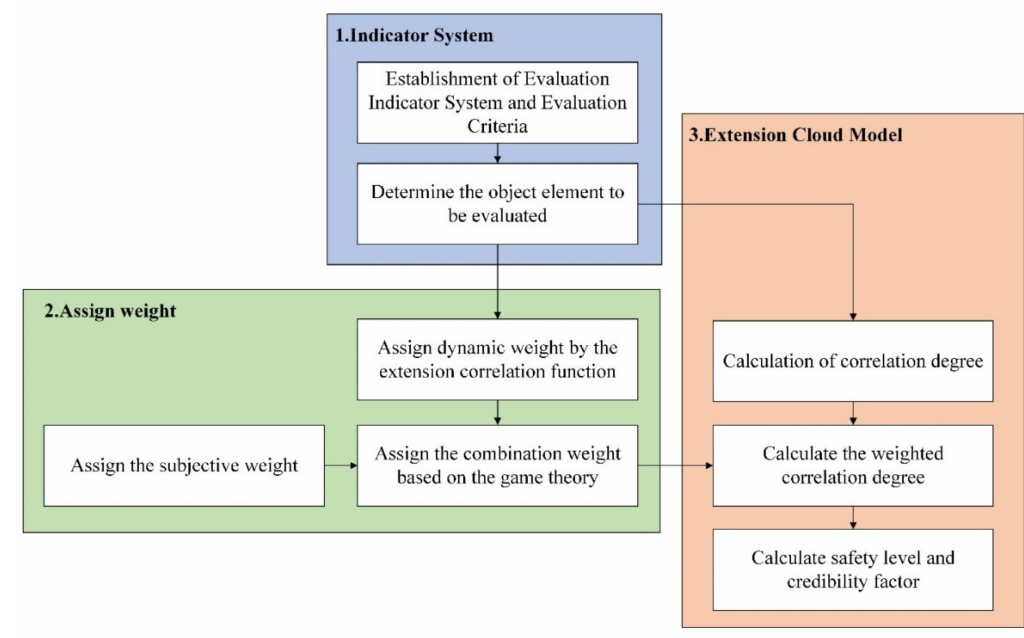
Figure 1. The model framework for an emergency situation safety evaluation after collisions at